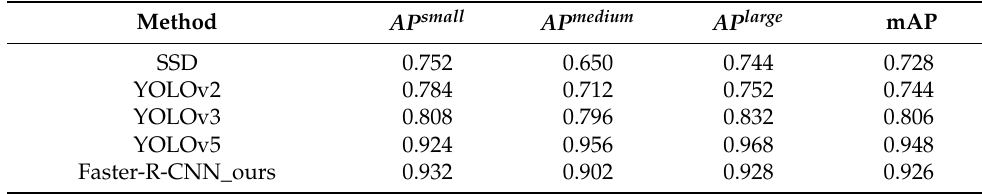
Table 4. Results of the comparative experiments at